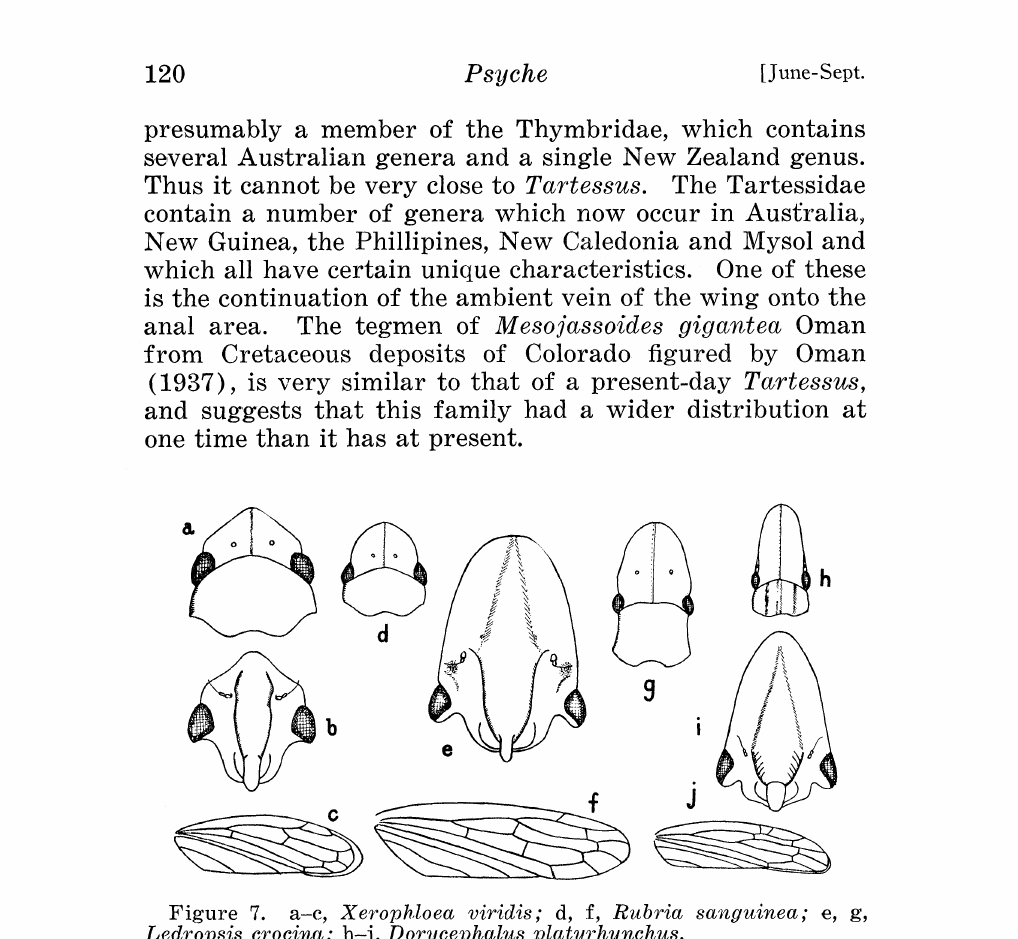
Figure 7. a-c, Xerophloea viridis; d, f, Rubria sanguinea; e, g, Ledropsis crocina h-j, Dorycephalus platyrhynchus.